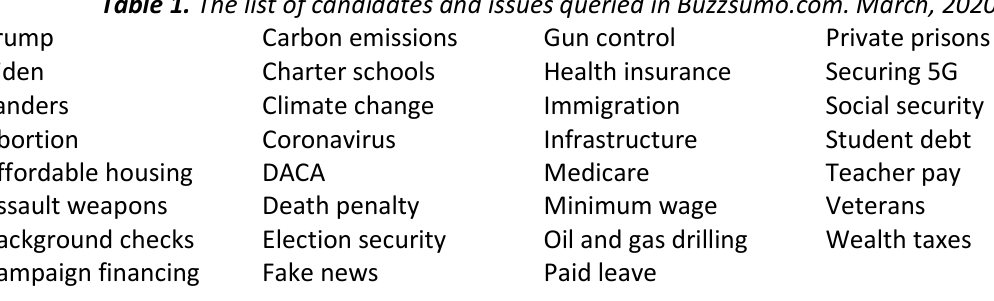
Table 1. The list of candidates and issues queried in Buzzsumo.com. March,